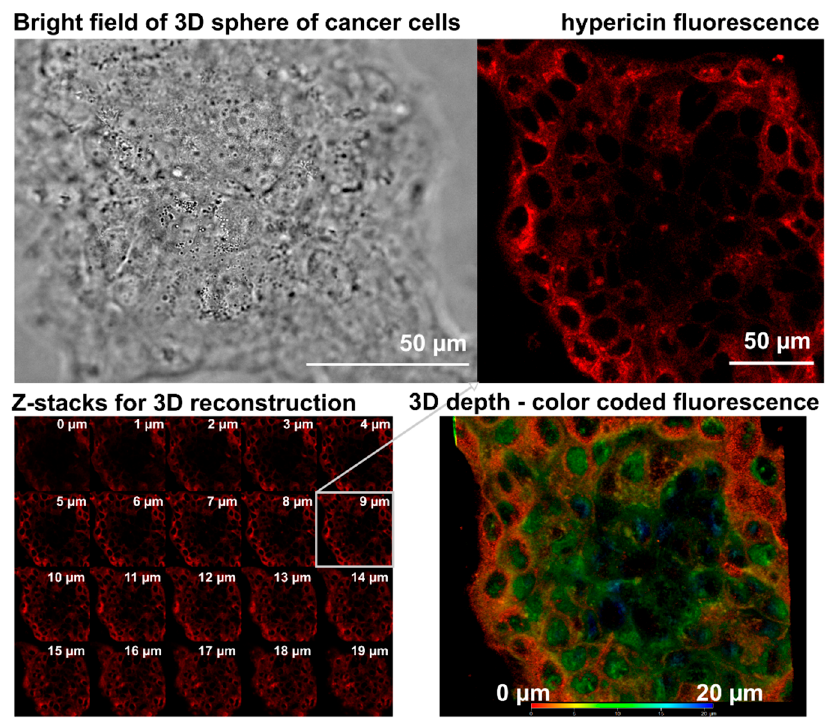
Figure 4. Representative brightfield ( top left ) and hypericin fluorescence ( top right ) images of BT 474 cancer cell spheroid. The spheroid was acquired in Z-stack ( bottom left ) and reconstructed in 3D ( bottom right ). The depth of hypericin fluorescence in the spheroid is color coded.